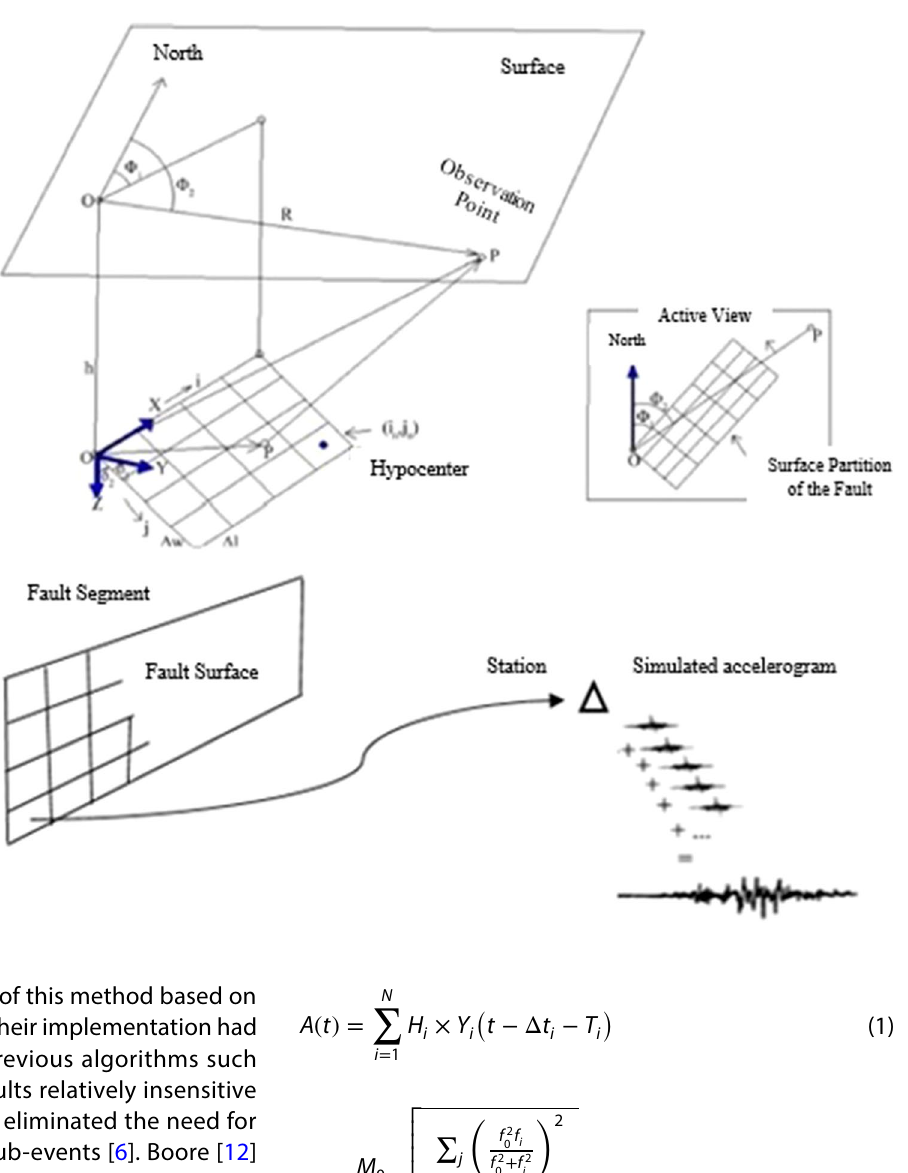
Fig. 3 Finite-fault model for dividing the fault plane into N sub-faults